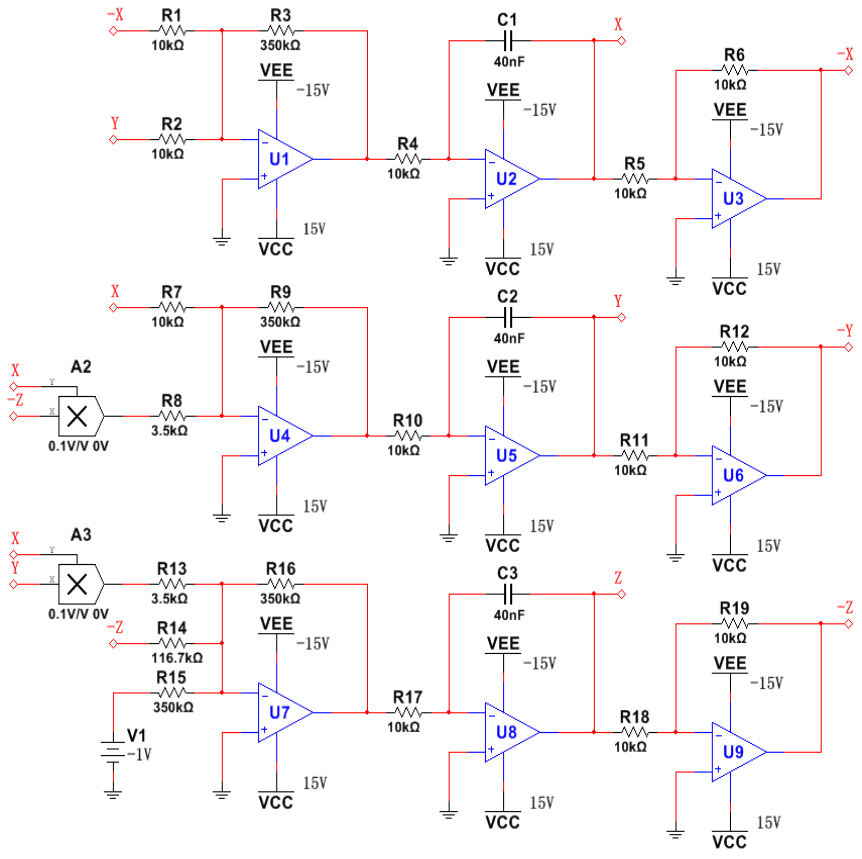
Figure 15. Circuit diagram of system